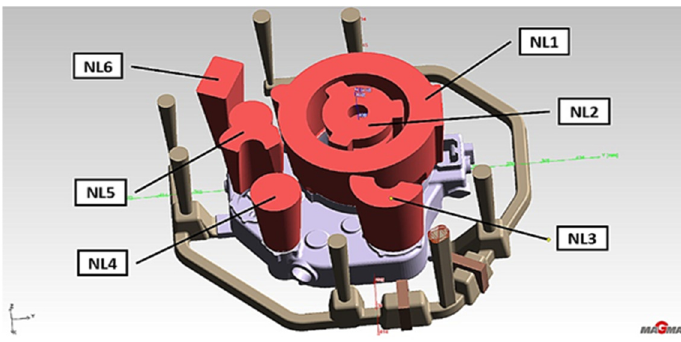
Figure 13. Stage 4-Feeding system through the gravity top risers.